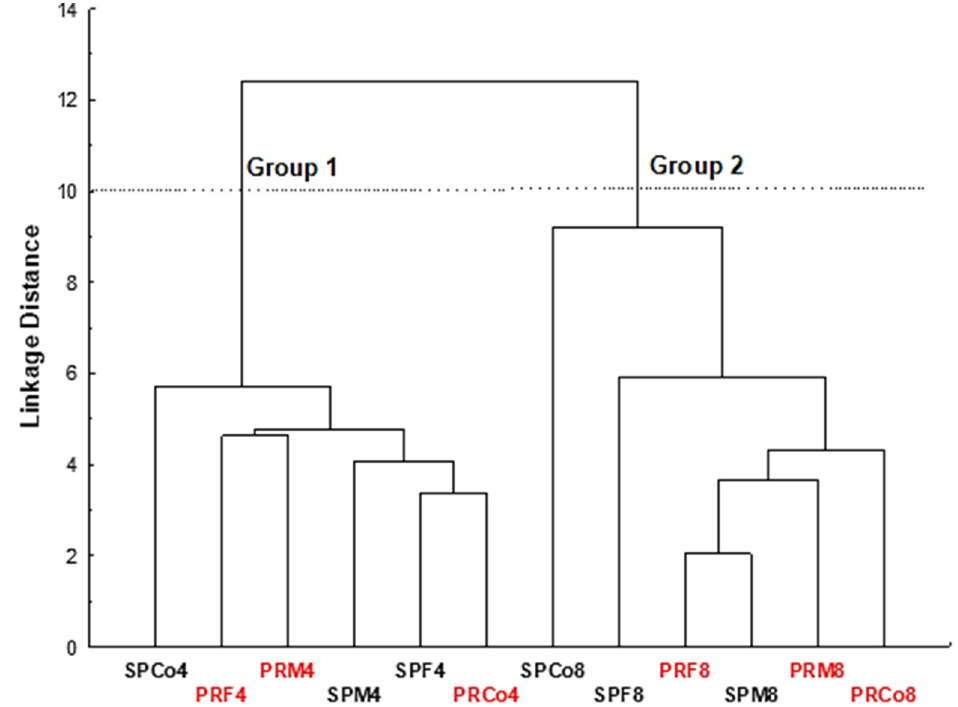
Figure 3. Hierarchical cluster analysis (HCA) of B. trimera and B. myriocephala ethyl acetate fractions according to the levels of polyphenol and antiradical activity. Co = commercial samples, F = female specimens, M = male specimens SP = São Paulo state, and PR = Paraná state. The presented numbers are related to the pH conditions used to obtain each fraction